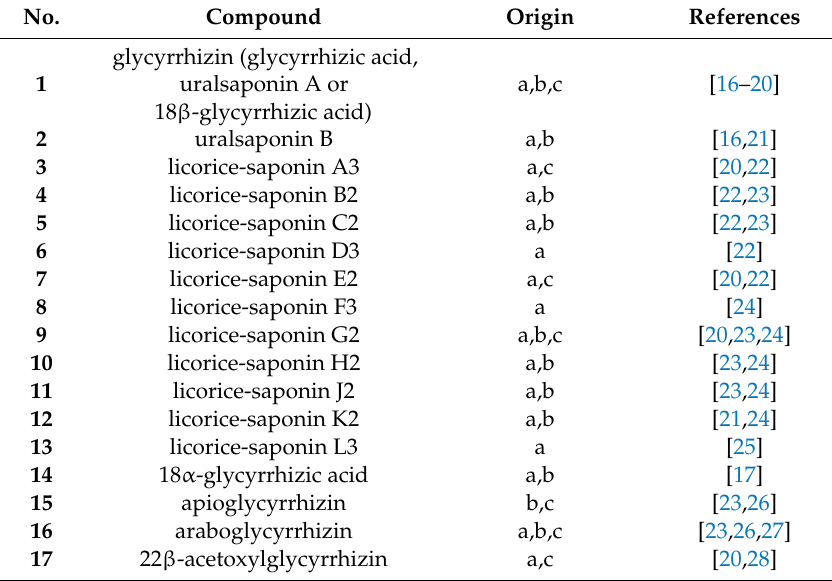
Table 1. Information on triterpene saponins in